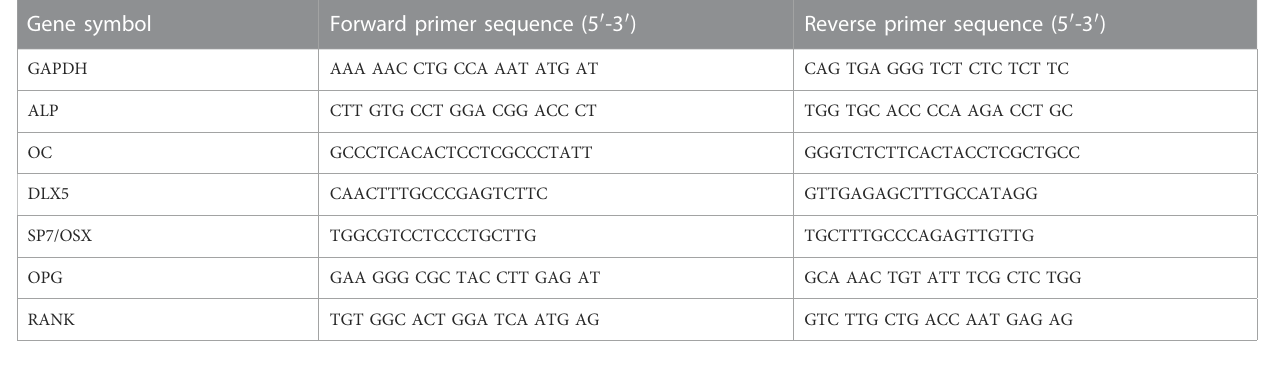
TABLE 1 Forward and reverse primer sequences of gene symbols. Gene symbol Forward primer sequence (5 ′ -3 ′ ) Reverse primer sequence (5 ′ -3 ′ )